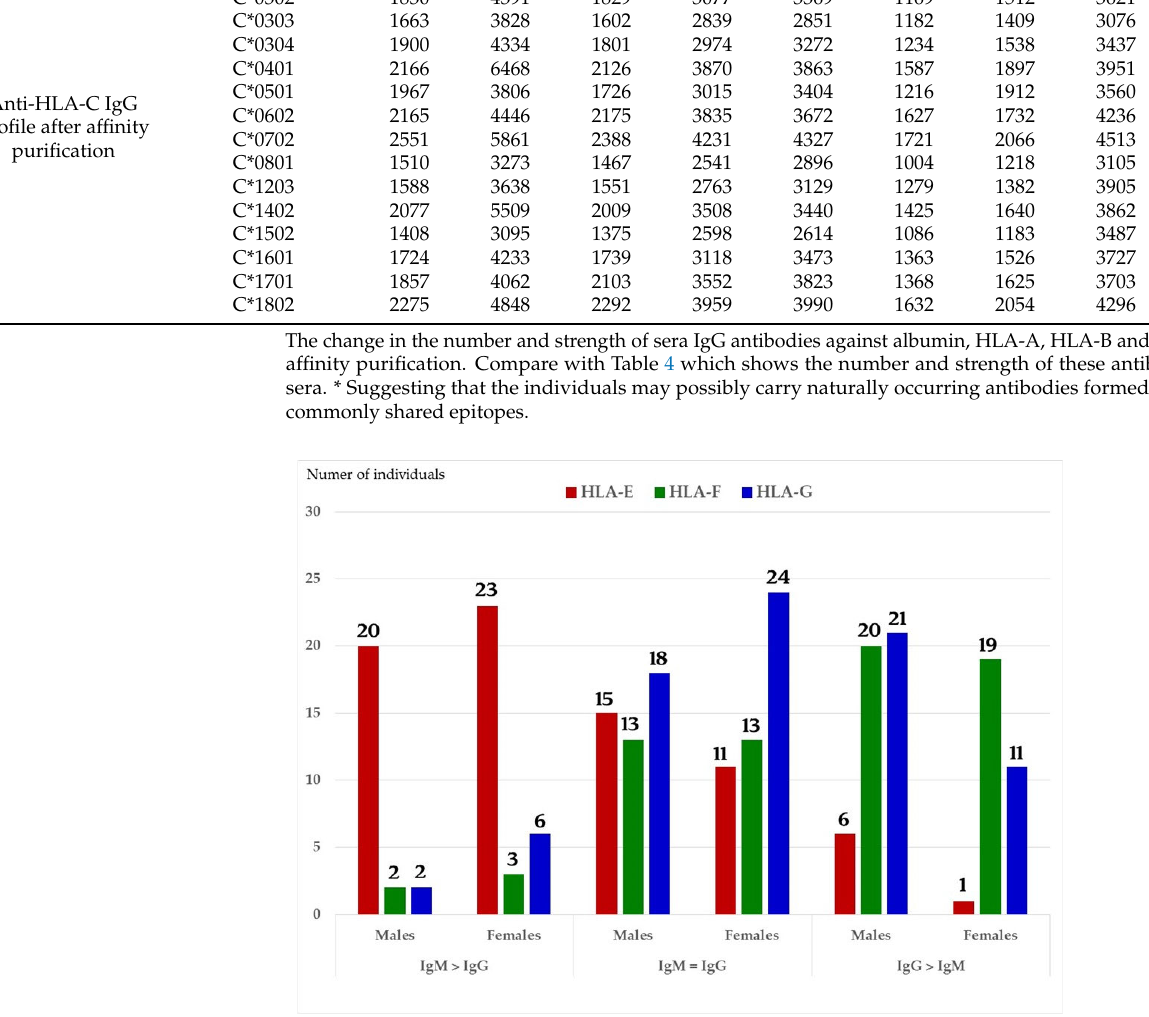
Figure 8. The relative ratios of IgM and IgG in the sera of normal males (non ‐ alloimmunized) and females. Note the high prevalence of IgM Abs against HLA ‐ E in a number of males and females, and high prevalence of IgG Abs against HLA ‐ G.